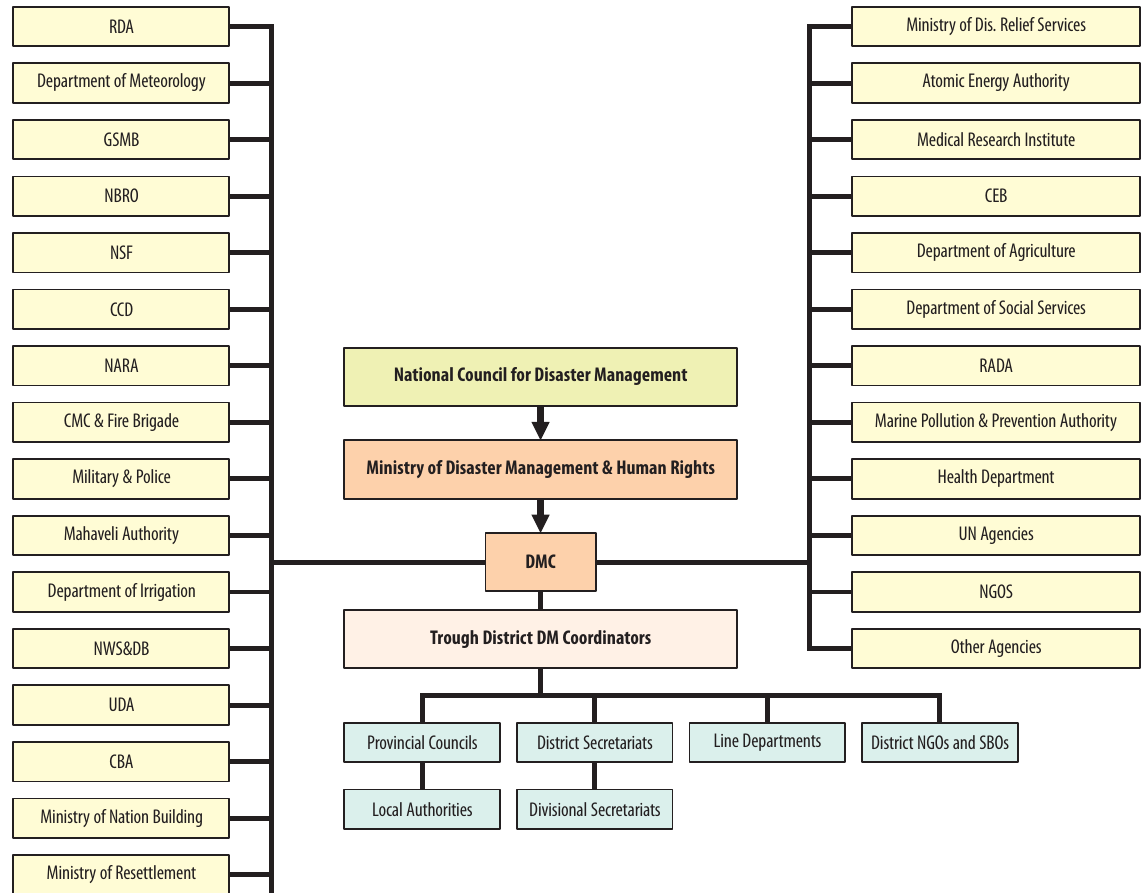
Figure 6. Stakeholders of disaster management cen Source: DMC